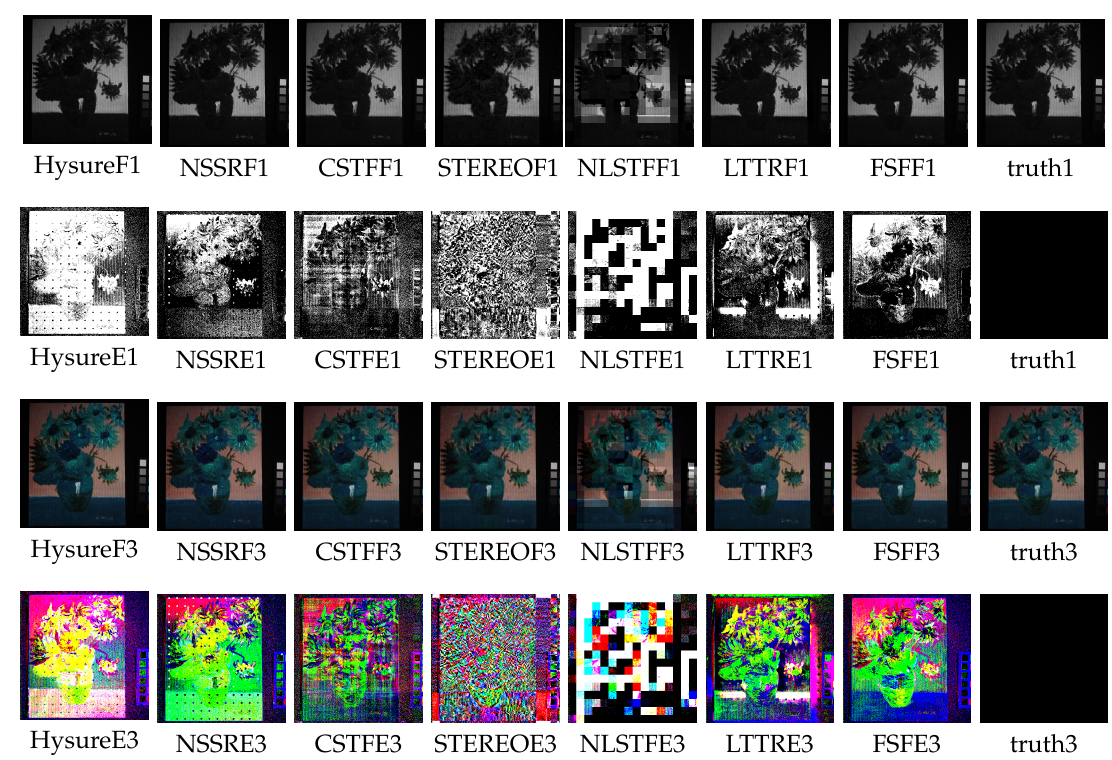
Figure 5. First row: the competing approaches to reconstructed images of oil_painting in the CAVE database at 10th band. Second row: the corresponding error images of the 10th band. Third row: the competing approaches to reconstructed images’ false-color images formed by bands 10th, 19th, and 28th. Fourth row: the corresponding error images of the false-color